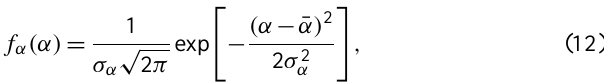
the particle surface as opposed being equally probable